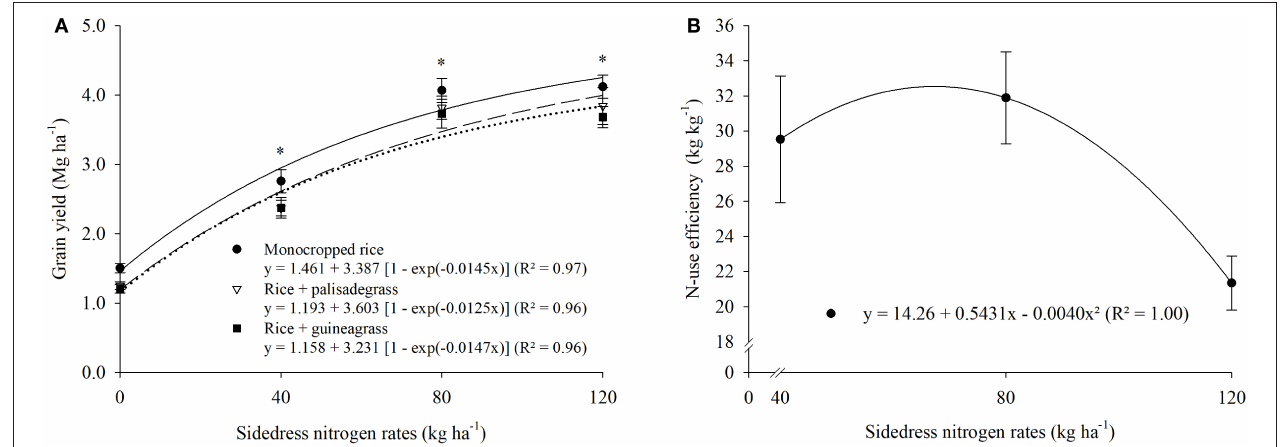
Forage Dry Matter Production and Crude Protein and Economics An advantage of intercropping systems compared with monocropping was the production of forage in the off-season. Palisadegrass intercropped with rice provided greater forage DM production, estimated animal stocking rate (SR), and estimated meat production in both cuts compared with